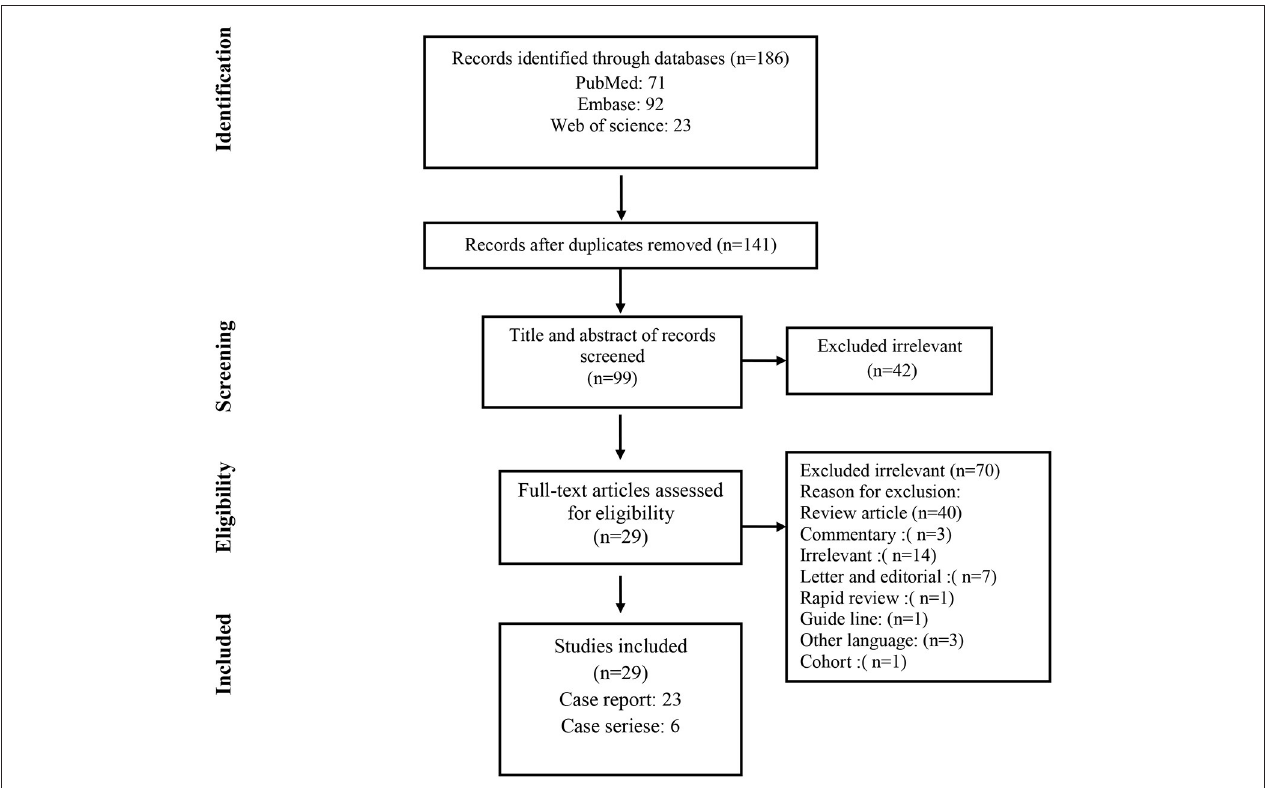
FIGURE 1 | Flow chart of study selection for inclusion in the systematic